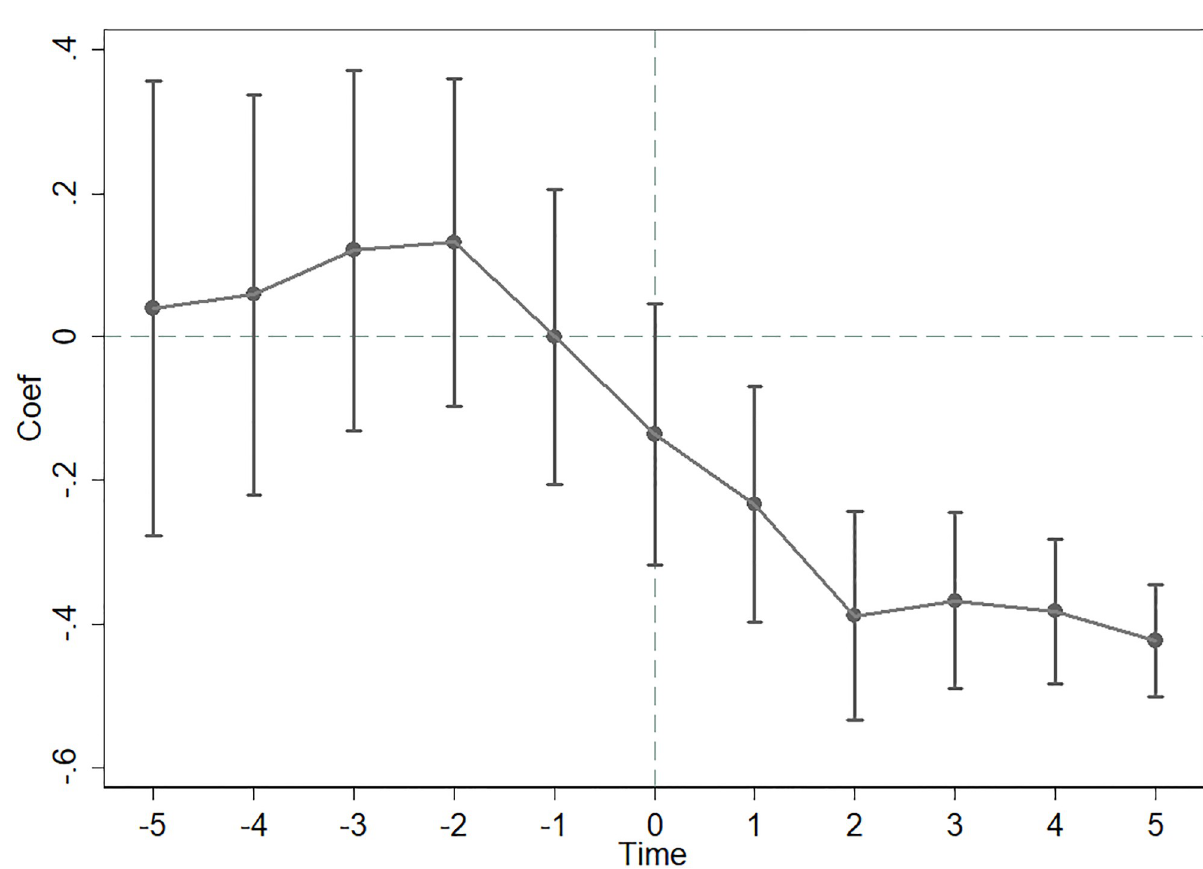
Fig 1. Dynamic analysis and parallel trend